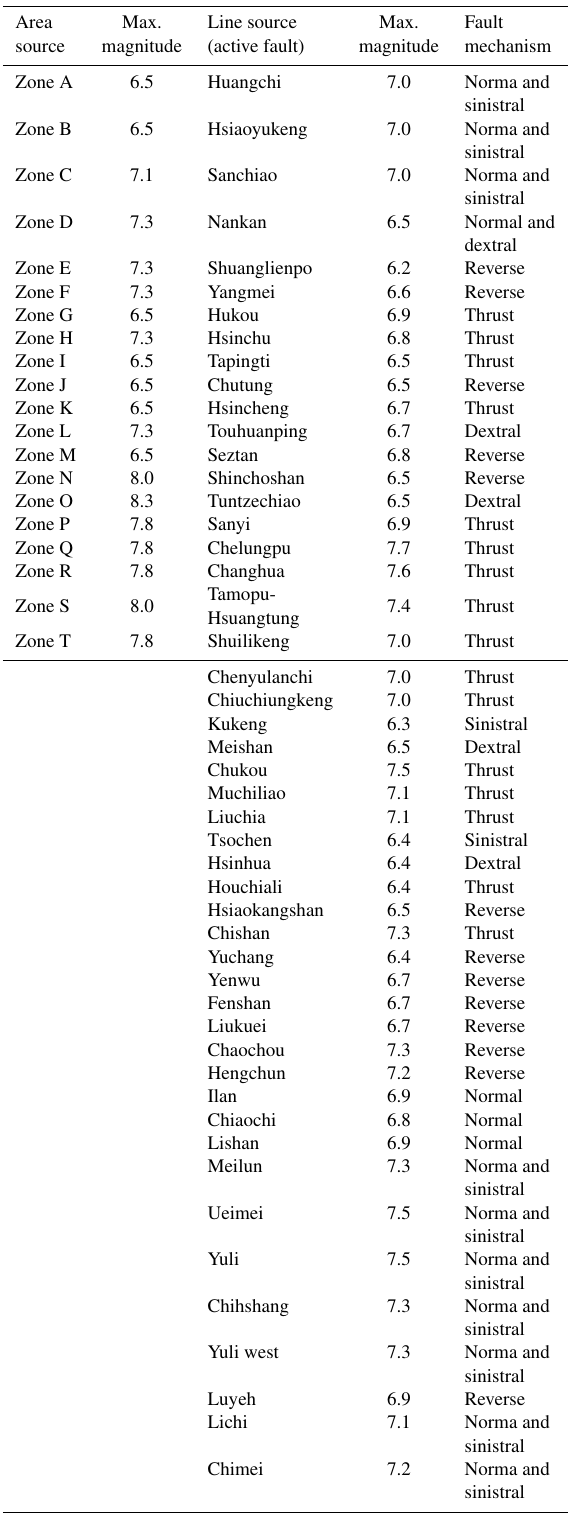
Table 1. Summary of maximum earthquake magnitudes (in M w ) of each seismic source around Taiwan.